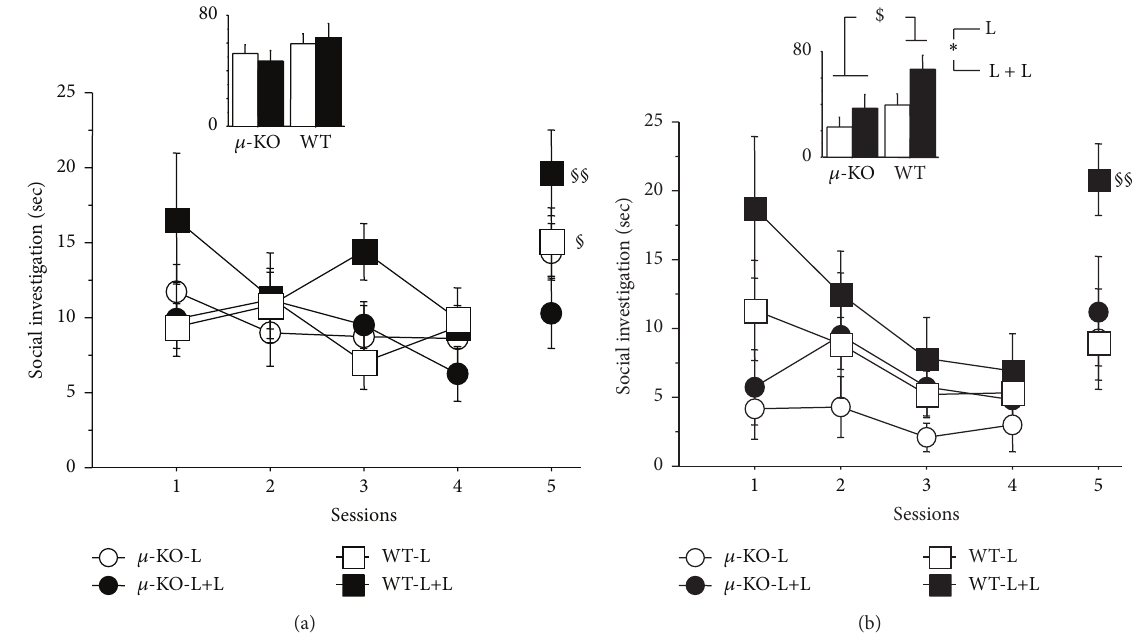
Figure 4: Mean time (+SEM) spent by female (a) and male (b) mice in social investigation of a younger same sex/genotype/standard reared intruder mouse during 5 consecutive 1min social interaction sessions (line graph). The same intruder was used during the first 4 sessions, while an unknown one (same characteristics) was introduced in the fifth session. Histograms represent the total amount of investigation shown during the five sessions by different experimental groups. 𝑁 : 8–15 per group. 𝜇 -KO-L: Oprm1 −/− pups reared by their mother [10 males + 15 females]; 𝜇 -KO-L+L: Oprm1 −/− pups reared by their mother plus a second lactating female [9 males + 11 females]; WT-L: Oprm1 +/+ pups reared by their mother [10 males + 15 females]; WT-L+L: Oprm1 +/+ pups reared by their mother plus a second lactating female [8 males + 11 females]. Genotype difference: $ 𝑝 < 0.05 ; rearing condition difference: ∗ 𝑝 < 0.05 ; recognition of new partner (session 4 versus 5 and paired 𝑡 -test): § 𝑝 < 0.05 ( 𝜇 -KO-L and WT-L females) and §§ 𝑝 < 0.01 ( 𝜇 -KO-L+L males and